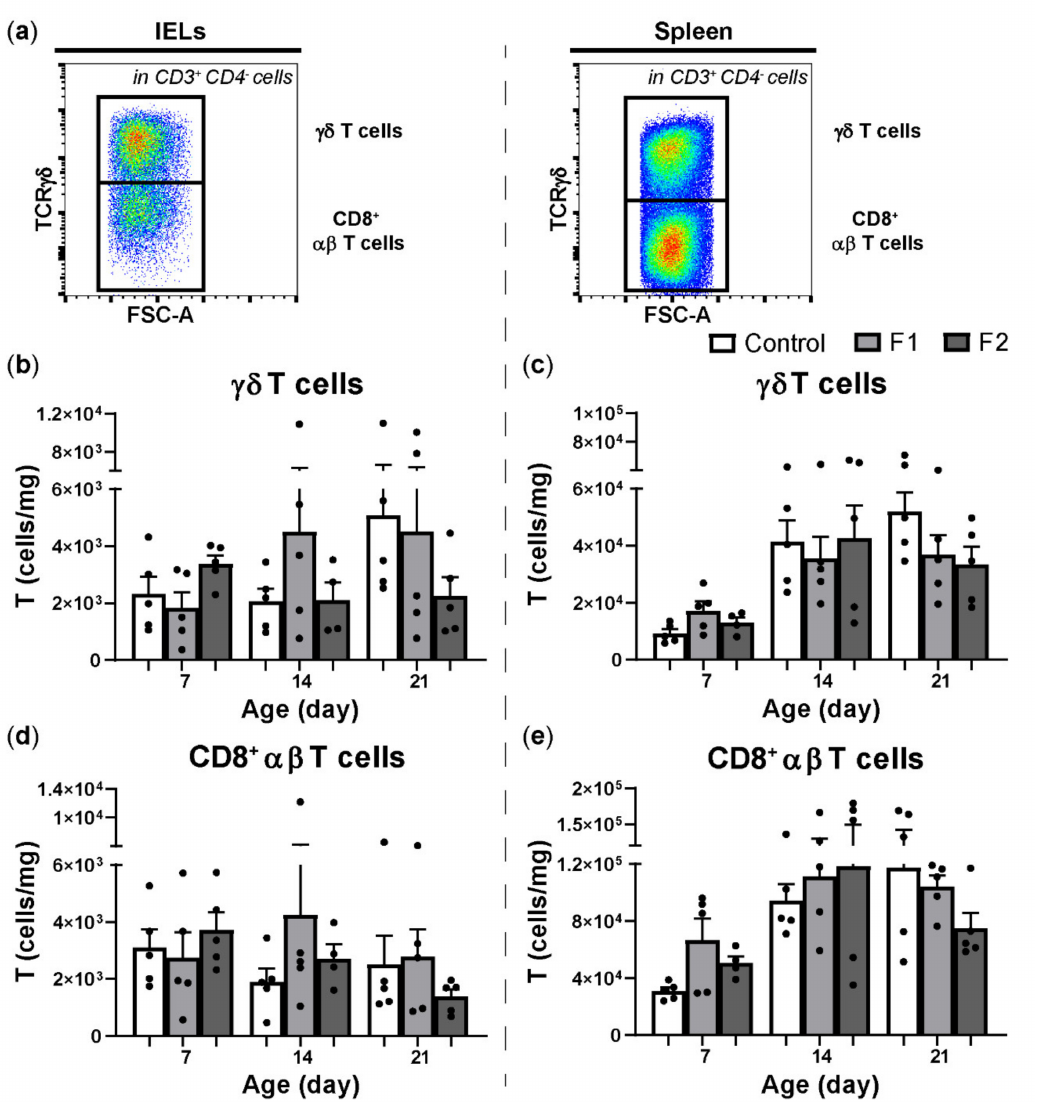
Figure 4. Effect of feeding glucose oligosaccharide and long-chain glucomannan to broiler chickens on T cell subsets. ( a ) CD3 positive and CD4 negative cells that are TCR γδ positive ( γδ T cells) or negative (CD8 + αβ T cells) in the IEL population (left panel) and spleen (right panel). ( b ) Numbers (cells/mg) of intraepithelial γδ T cells and ( d ) CD8 + αβ T cells in broiler chickens fed with different diets in the course of time. ( c ) Numbers (cells/mg) of splenic γδ T cells and ( e ) CD8 + αβ T cells in broiler chickens fed with different diets in the course of time. Mean + SEM is shown ( n = 5) of chickens provided standard diet (control), feed supplemented with glucose oligosaccharide (F1), or long-chain glucomannan